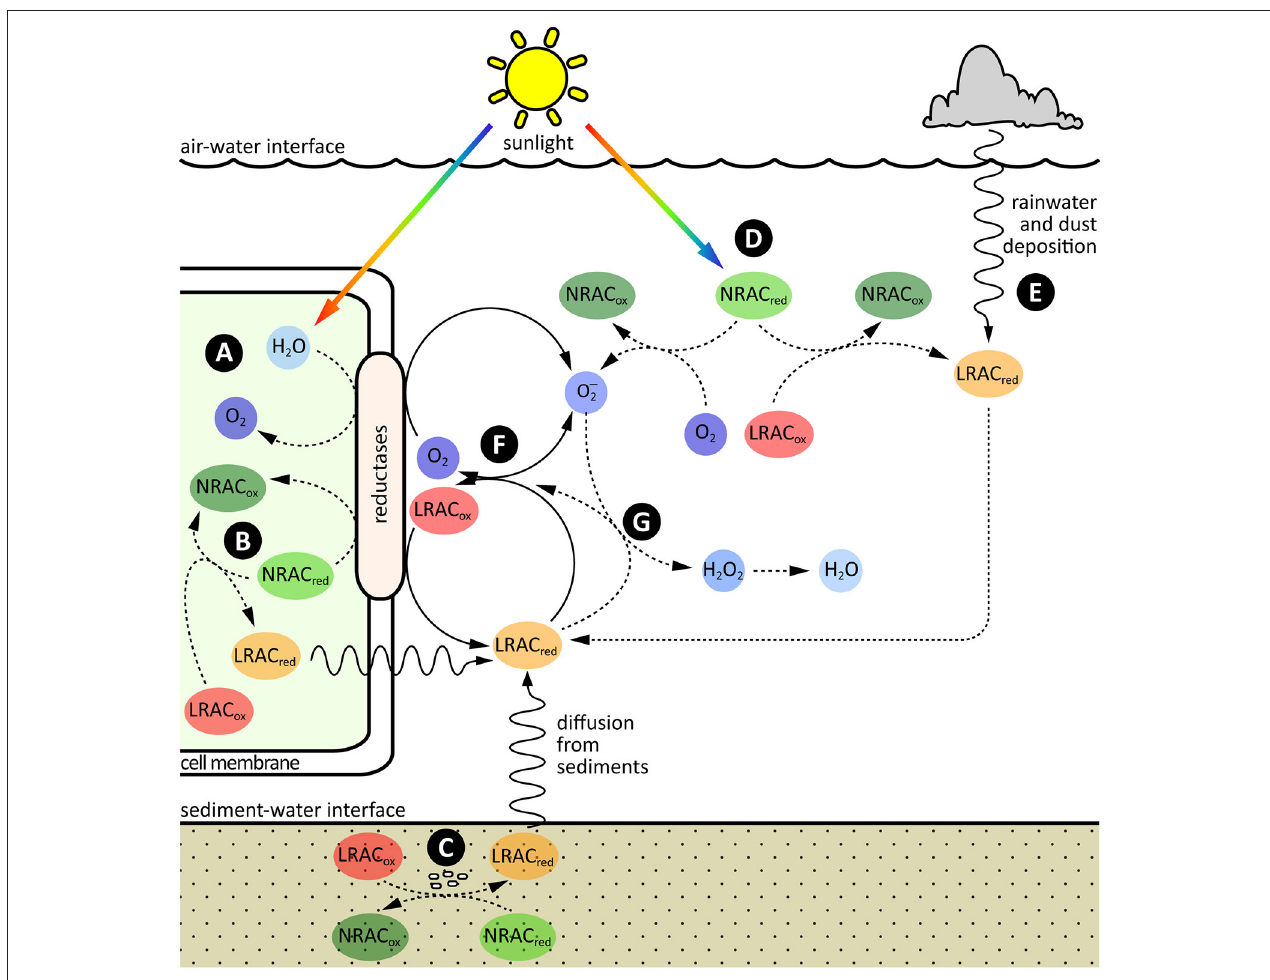
FIGURE 3 | Sources, sinks and cycling of electrons in the LRAC pool. The major sources of electrons are: (A) Photosynthetic oxidation of water inside cells, with subsequent donation of electrons to LRACs in the extracellular environment through membrane associated oxidoreductase enzymes, or excretion of reduced LRACs through the cell membrane; (B) Respiratory oxidation of organic carbon or other non-labile redox active compounds (NRACs) inside cells, with subsequent donation of electrons to LRACs in the extracellular environment through membrane associated oxidoreductase enzymes, or excretion of reduced LRACs through the cell membrane; (C) Respiratory oxidation of other reduced NRACs in reducing environments such as sediments, with subsequent physical transport of reduced LRACs into overlying oxygenated surface waters; (D) Abiotic, photochemical oxidation of reduced NRACs in sunlit surface waters; and (E) Abiotic, photochemical oxidation of water or reduced NRACs in the atmosphere, with subsequent deposition of reduced LRACs into oxygenated surface waters through dust or rain. (F) Once in the LRAC pool, electrons can potentially be readily exchanged between a range of different LRAC redox couples, including the O 2 /O − 2 couple. (G)